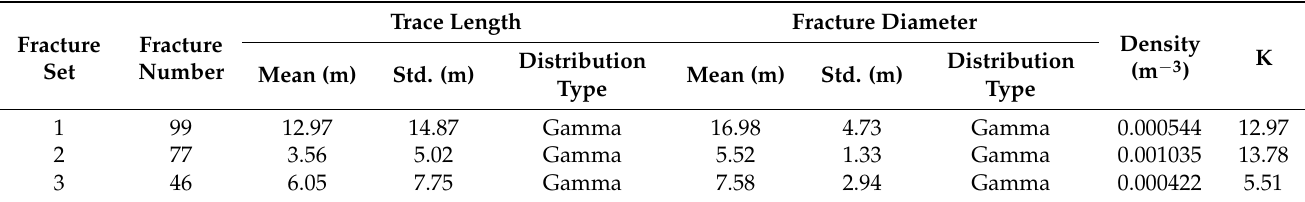
Table 1. The parameters of fractures used to generate the 3D network